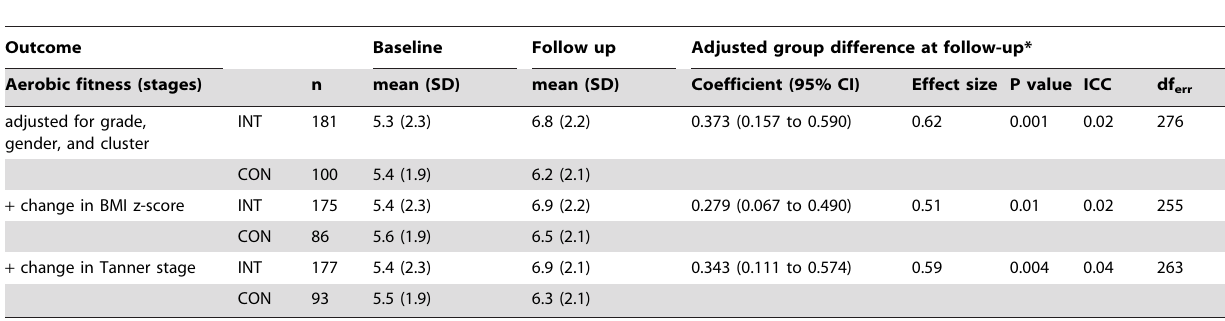
Table 4. Additional analyses for aerobic fitness when additionally adjusted for change in body mass index or change in pubertal stage. Values at baseline and follow-up are unadjusted means